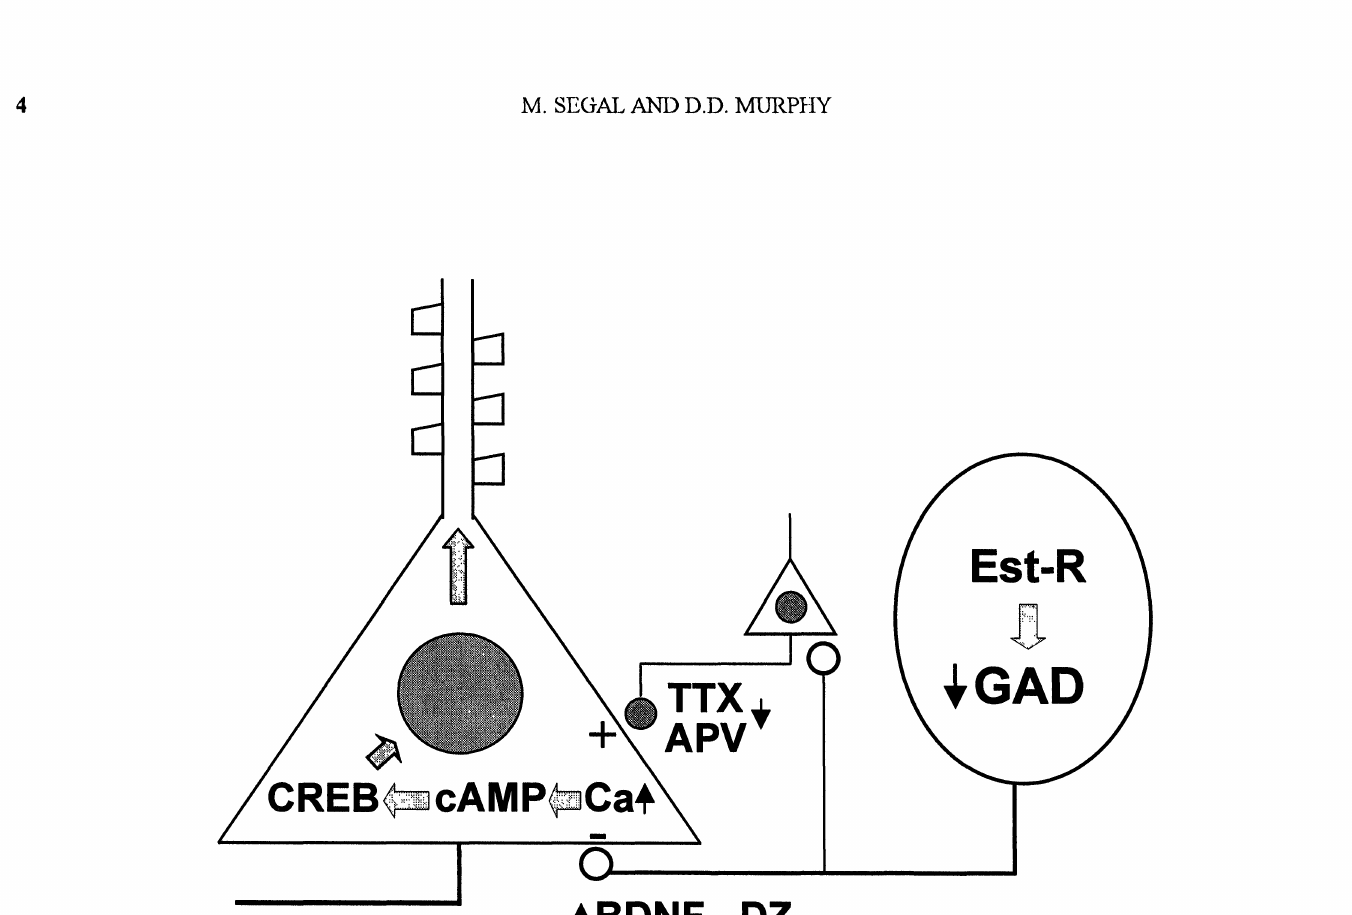
O +BDNF, DZ Fig. 2: Schematic diagram of the current hypothesis on the link between estradi61, calcium, CREB, and spine formation. Estrogen receptors in interneurons downregulate GAD, which causes a reduced inhibition of pyramidal neurons (triangles). The increased excitation causes (a) an increased influx of calcium, (b) the formation of cAMP, pCREB, and dendritic spines. Adding either TTX or APV blocks the effect of estradiol by reducing excitation; BDNF and diazepam (DZ) block the effects of estradiol by enhancing